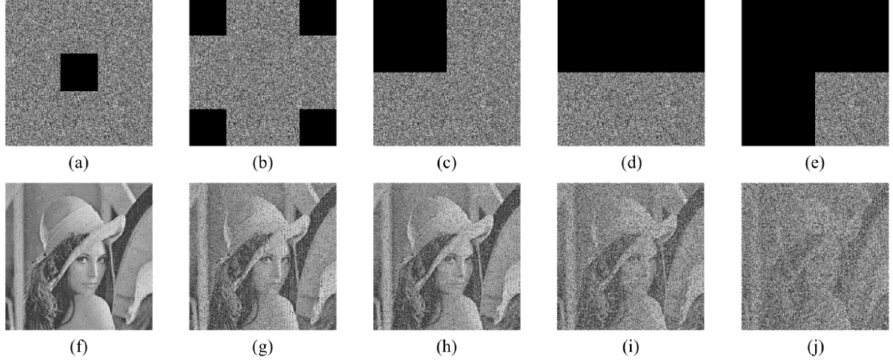
Figure 12. ( a – e ) are crop attacks at different clipping scales. ( f – j ) are the decryption results of ( a – e ).